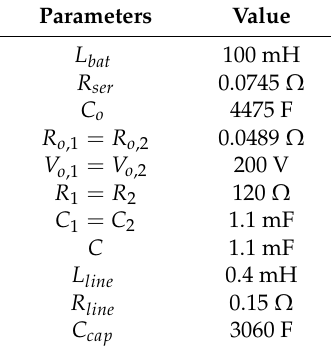
Table 1. System Parameters.